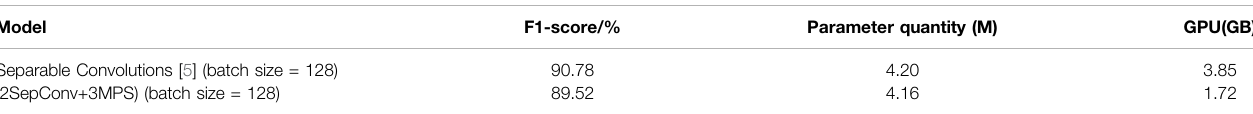
TABLE 5 | Performance comparison between the separable convolution model and the separable convolution model combined with tensor networks.